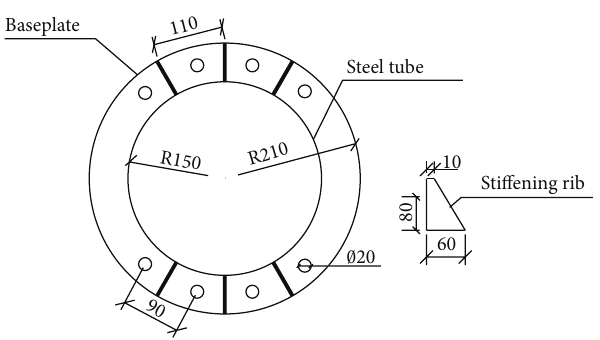
Table 2: Mix proportions of self-compacting concrete with high fluidity (kg/m 3 ). Figure 2: Details of the steel flange (unit: